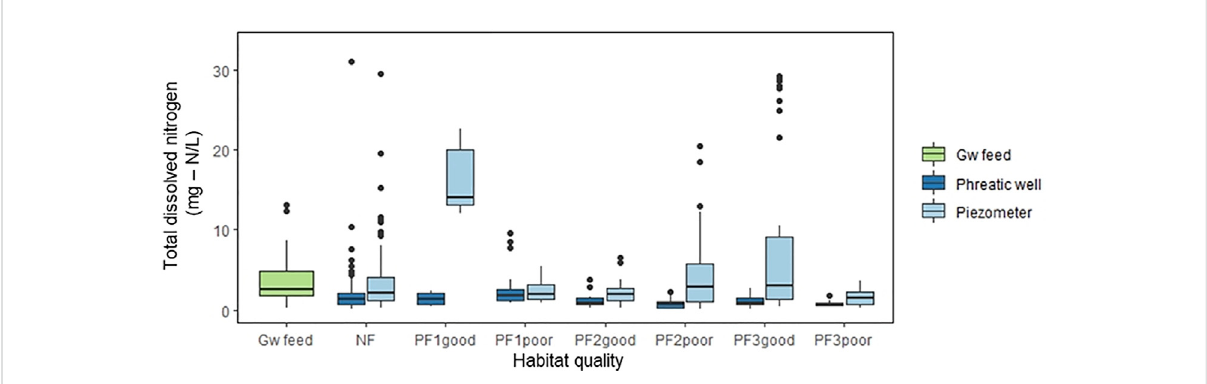
FIGURE 7 Totaldissolvednitrogen(mg-N/l)forcalcareousfenvegetationFossitthabitattypesPF1,PF2,andPF3inthefenphreatictubesandpiezometers of good, poor or non-fen (Other) habitats, and groundwater (Gw) feed from the wider